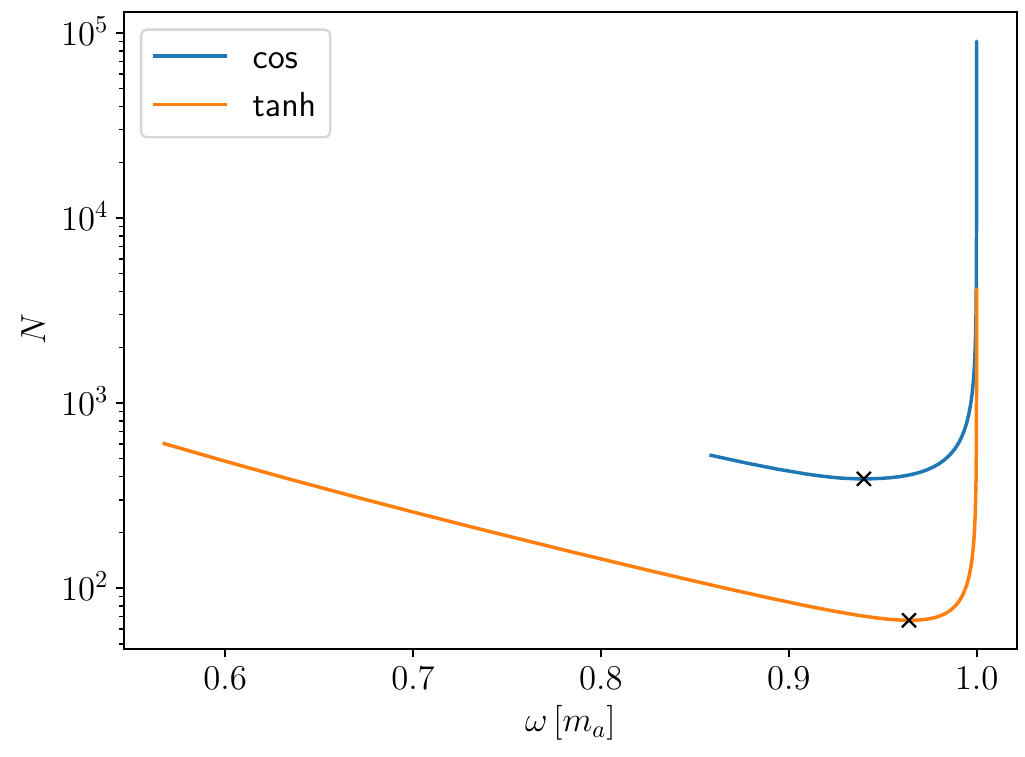
Figure 3 . Particle number N as defined by (3.7) as a function of the clump frequency ω for the cos- and tanh-potential. The leftmost point on each curve is where the central amplitude ˜ φ = 5 f a . For a given curve, the x marks the critical frequency for which the solutions becomes unstable (3.8). lower to higher frequency (left to right), the solutions are stable until we pass the x, and are unstable